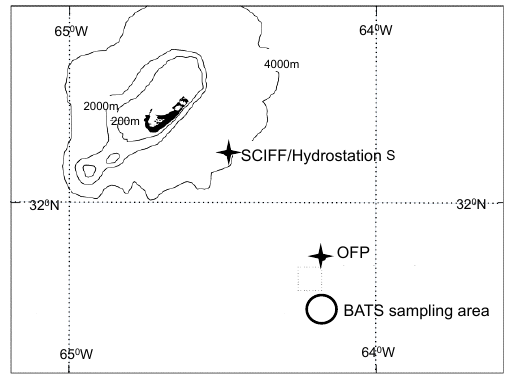
Figure 1. Map to show locations of the Oceanic Flux Program (OFP) mooring (31 ◦ 50 (cid:48) N, 64 ◦ 10 (cid:48) W) and the Bermuda Atlantic Time Series (BATS) hydrographic station (31 ◦ 40 (cid:48) N, 64 ◦ 10 (cid:48) W) and Seasonal Changes in Foraminifera Flux (SCIFF) site and Hydrosta- tion S in relation to